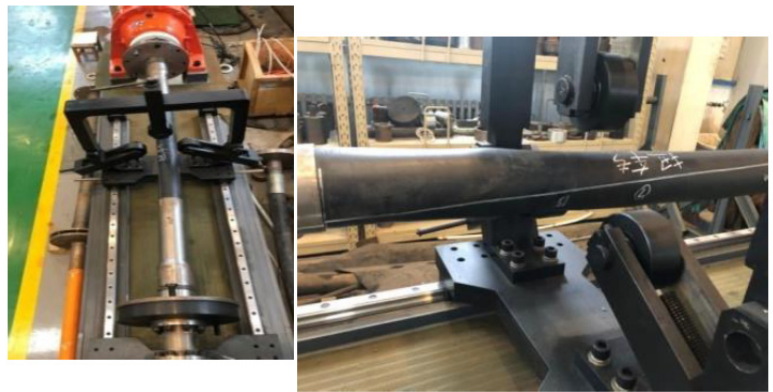
Figure 17. Torsion test of the RTP sample.